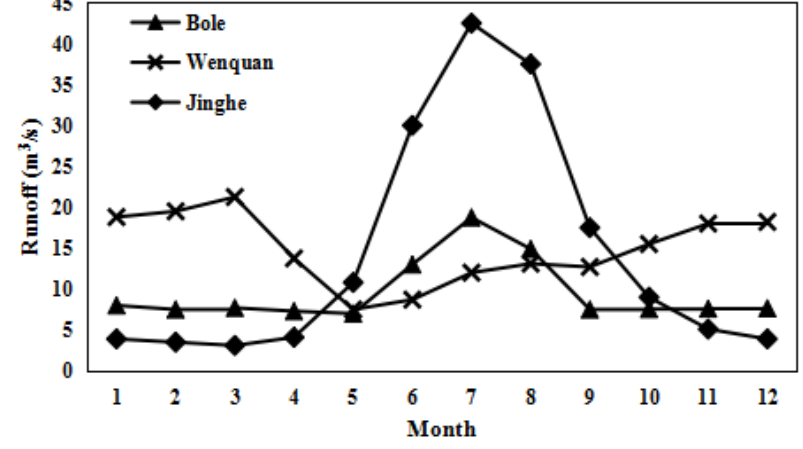
Figure 16. Average runoff distribution of Jinghe A’lashankou, Wenquan, and Bole from 1960 – 2015 [47].